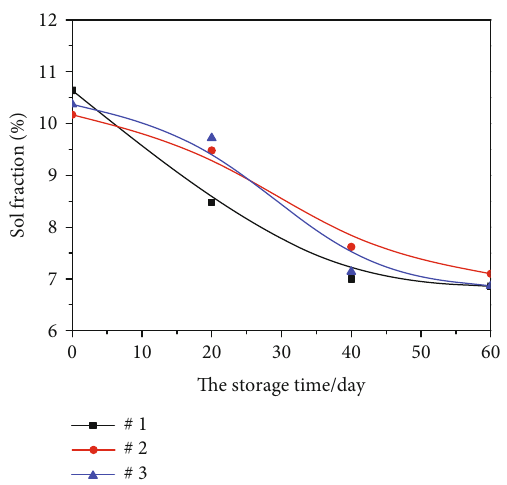
Figure 5: The variation of the sol fraction of the reclaimed rubber samples with storage time. Some amount of the molecular fragments with radical sites undergoes recombination and produces larger insoluble structures during the storage period causing the sol fraction to decrease.